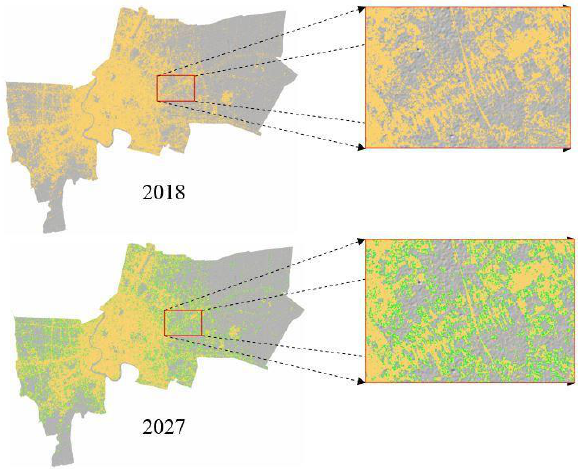
Figure 8. Urban growth prediction maps for Bangkok. Yellow colored pixels represent seed (2017) urban layer; green represent urbanized pixels at 80-94% probability. A small area is highlighted for clarity showing the expanded (green) pixels (Note: Map not drawn to